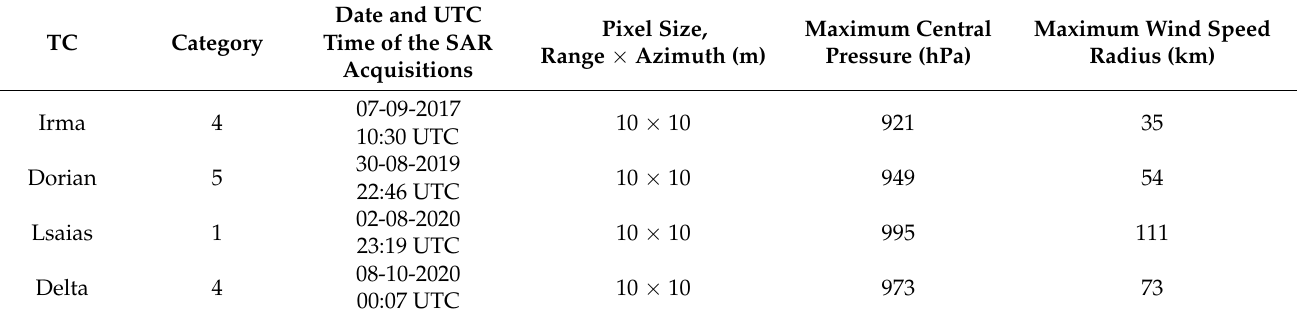
Table 1. Main SAR and ancillary information of the